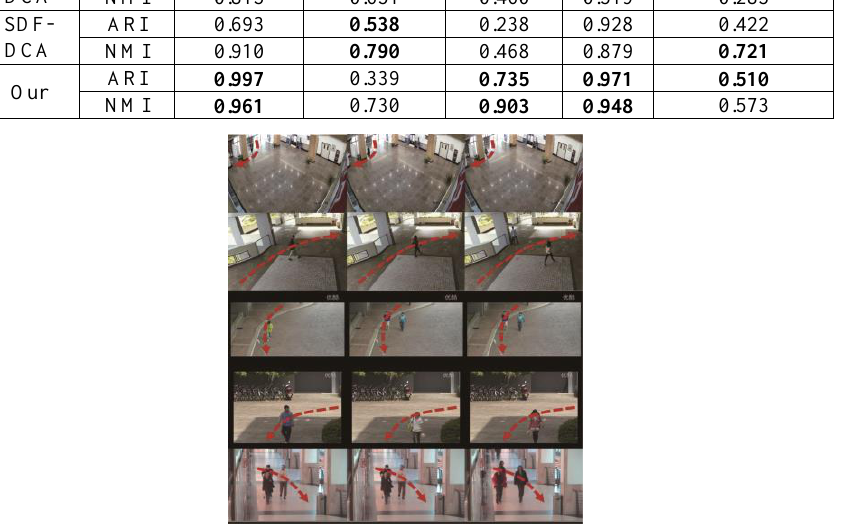
Fig. 7. Display of target trajectory in the same direction of original videos